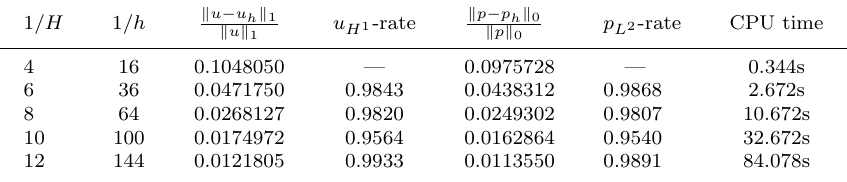
Table 3. Relative error and convergence rate of the two-grid method for the velocity and flux with τ 2 = h and ν = 0 . 1. 1 /H